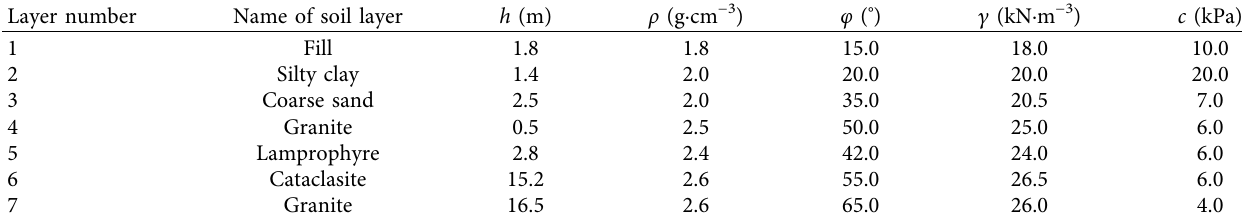
Table 1: Physical and mechanical properties of subsoil.